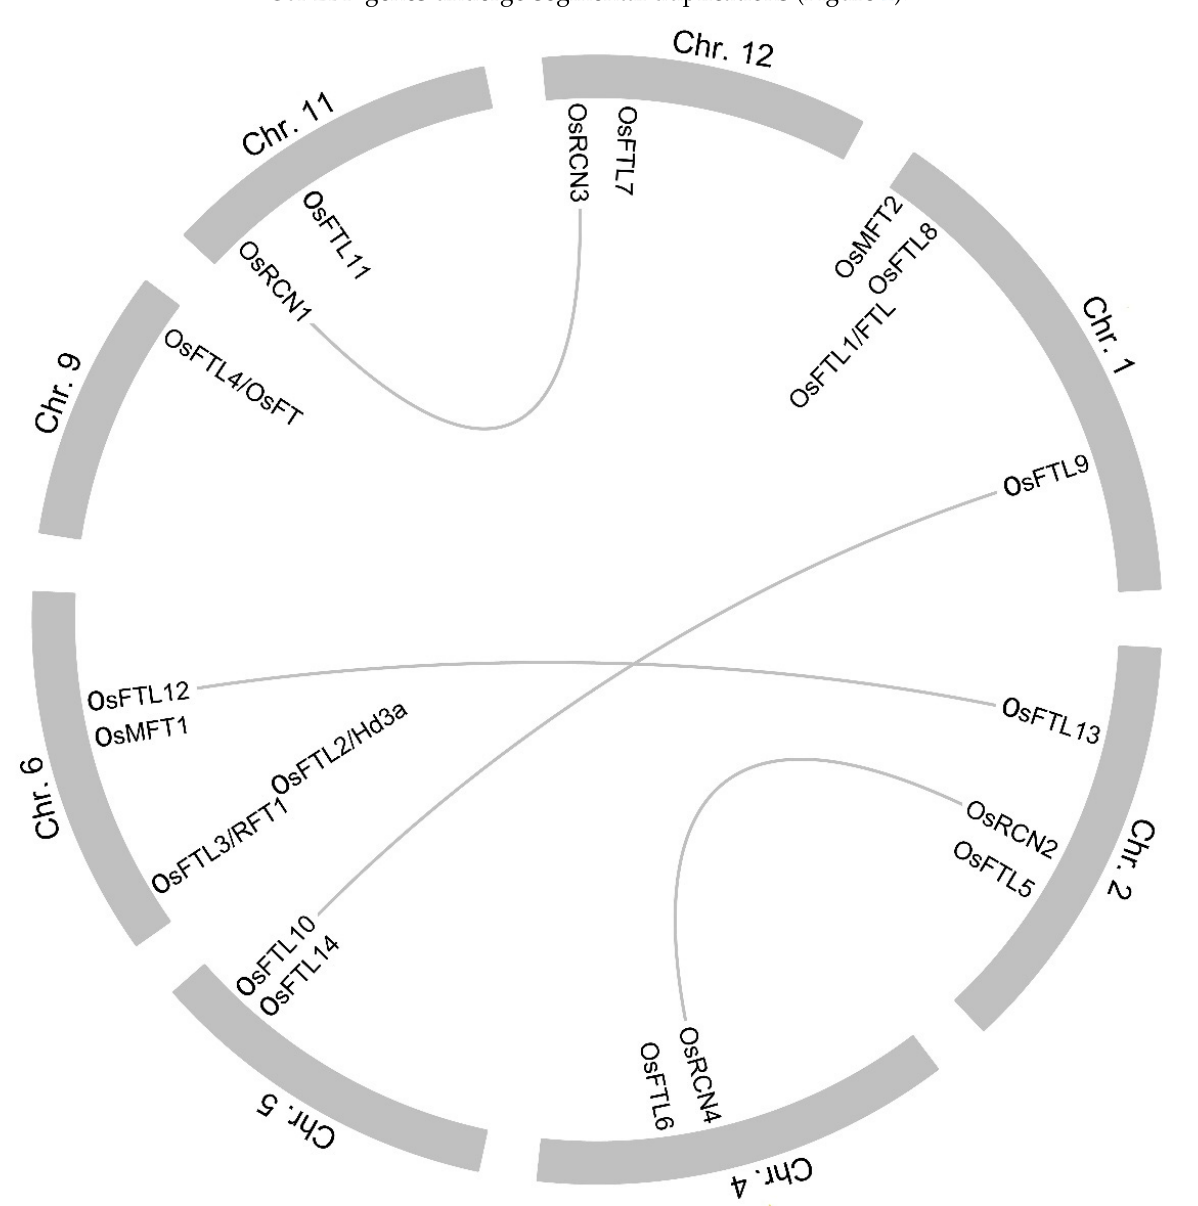
Figure 2. Syntenic analysis of OsPEBP genes in rice. Bars in gray show the rice chromosomes. Chromosome number is labeled on the peripheral surface. OsPEBP genes are labeled on the inner circumferential surface of each chromosome. The gray lines represent the colinear pairs of OsPEBP genes.